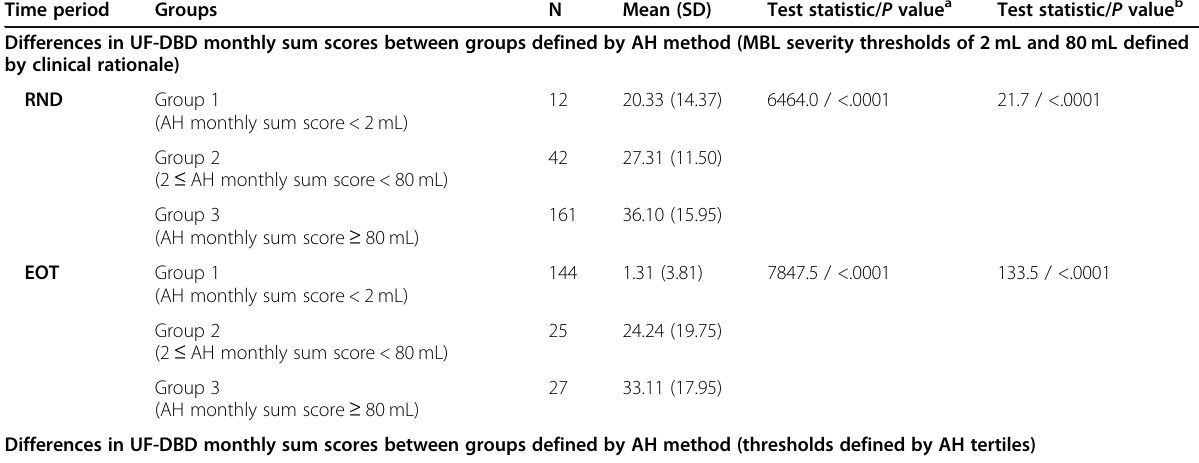
Table 5 Known groups validity analysis with UF-DBD and reference measures (monthly sum